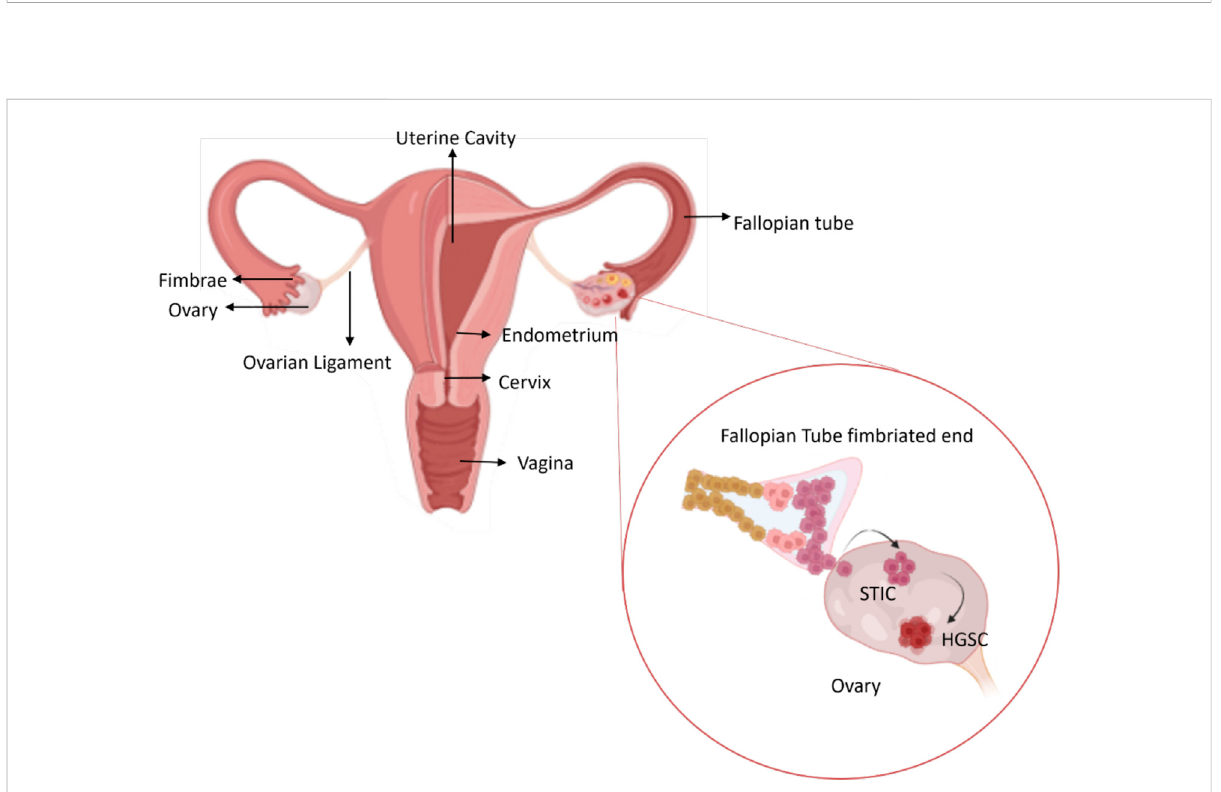
FIGURE 2 The origin of HGSC OC, most common form of EOC. A precursor lesion known as serous tubal intraepithelial carcinoma (STIC) in the fallopian tube are considered as the site for the origin of the malignant cells and involve the ovaries only secondarily (Created in